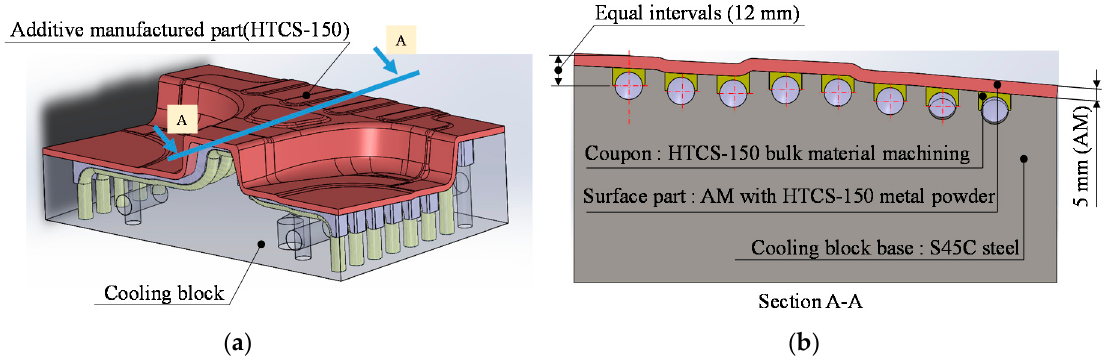
Figure 8. Fabrication concept for the conformal cooling channel using AM technology ( a ) cooling block iso-view ( b ) cooling block Section A-A.